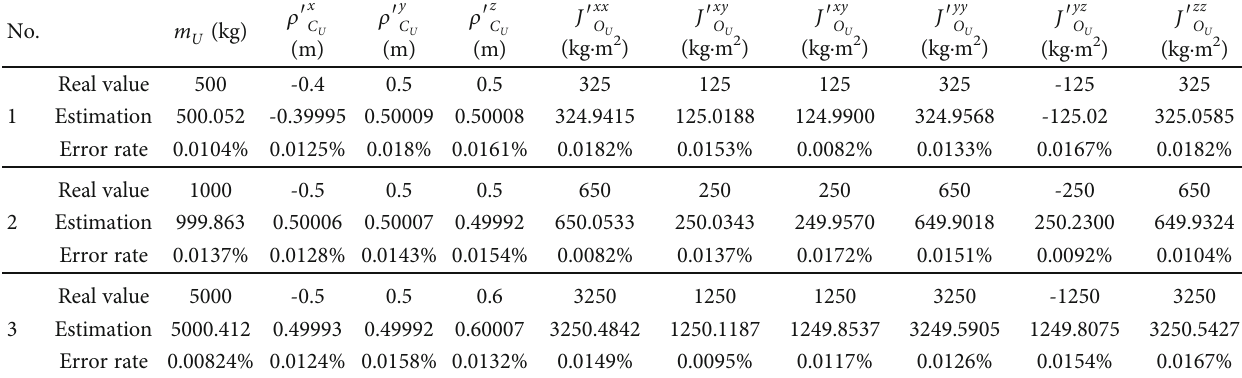
Table 5: Inertia parameters of the unknown